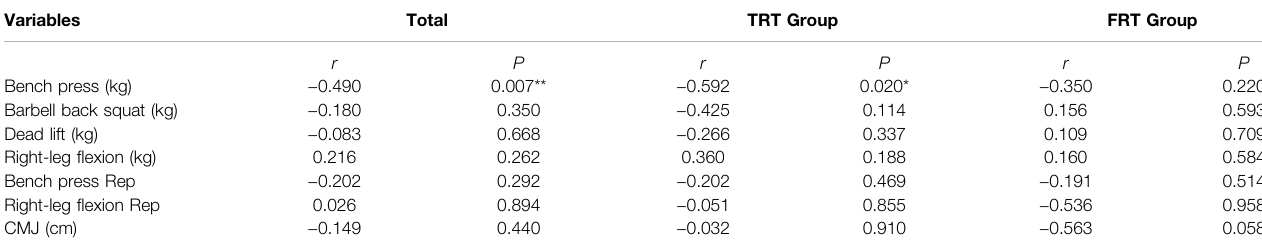
TABLE 3 | Correlations of delta value in CAVI with muscular fi tness components. Variables